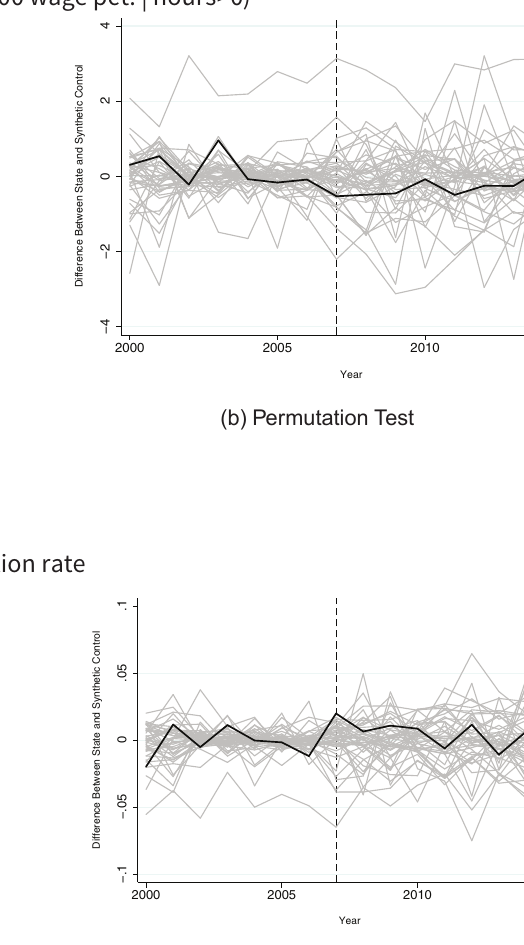
Figure A16 Native female weekly hours (75-100 wage pct. | hours>0)